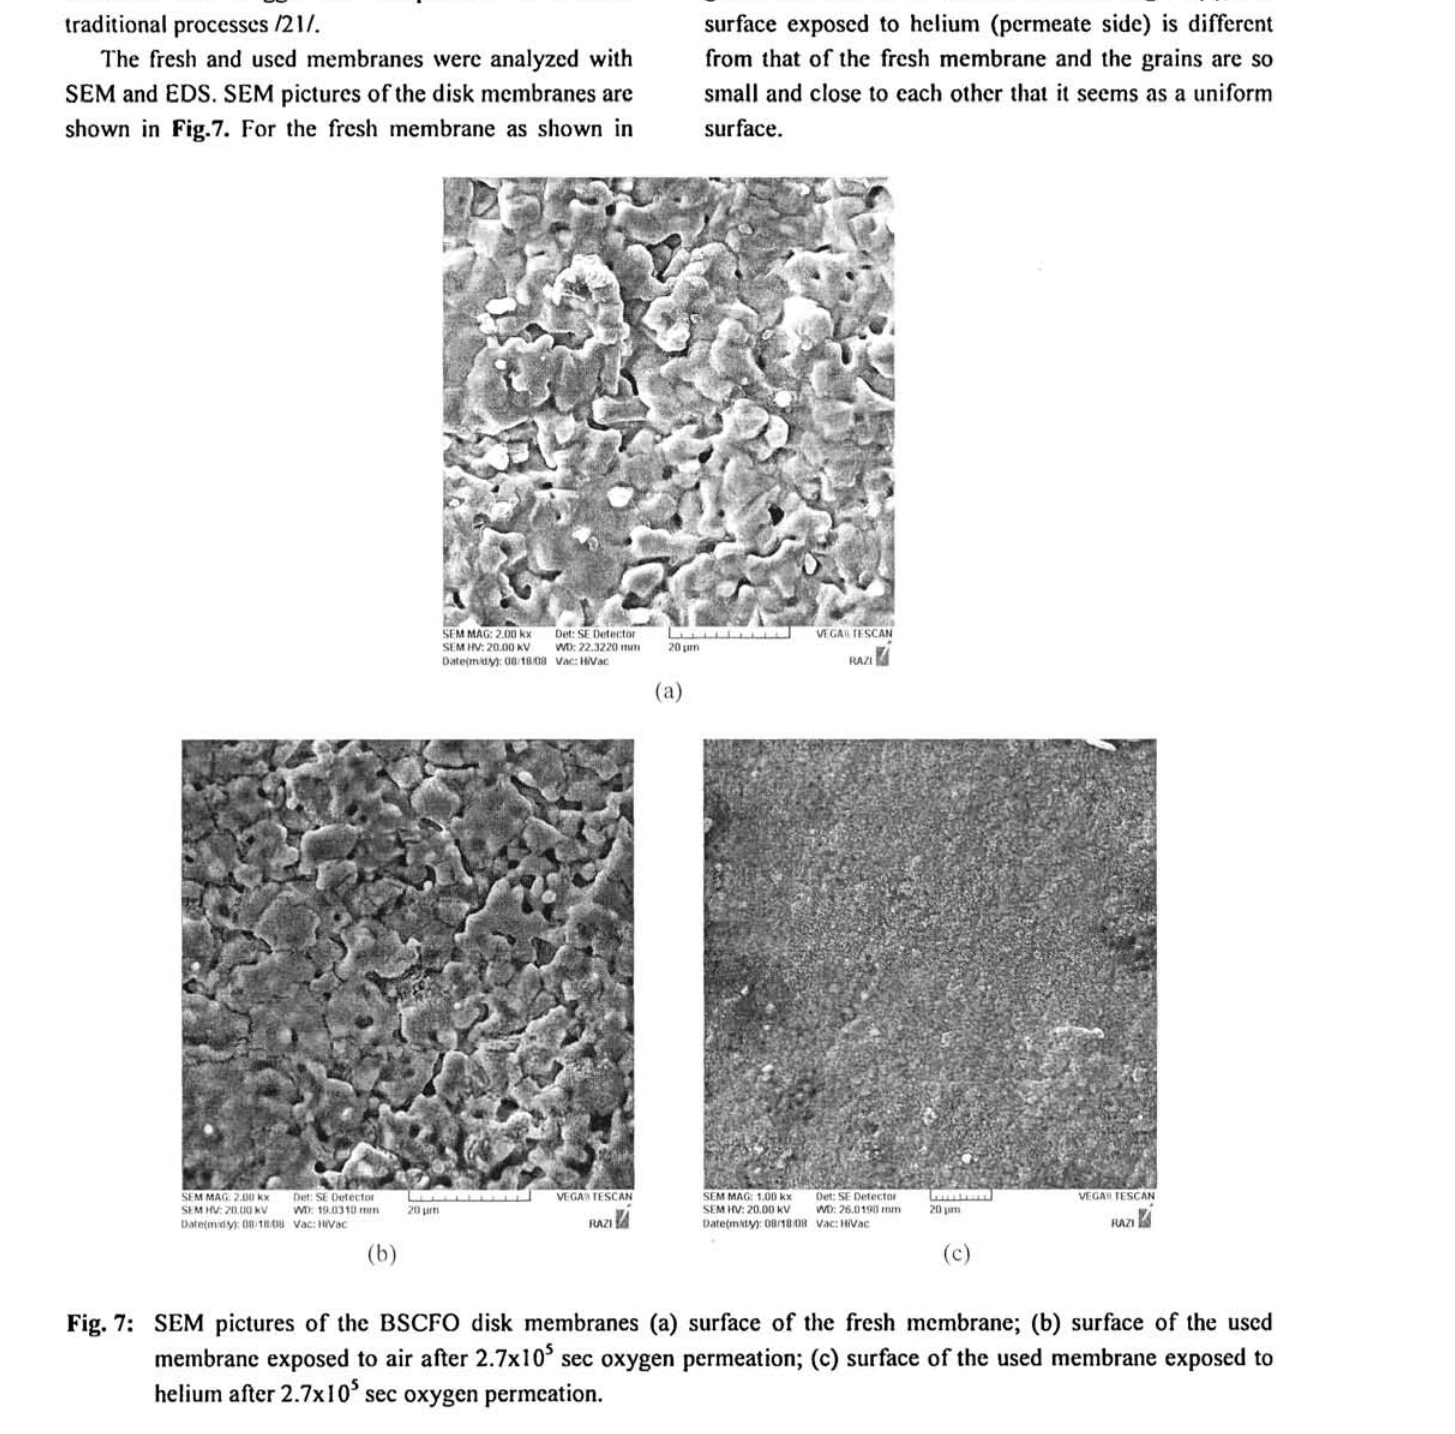
Fig. 7: SEM pictures of the BSCFO disk membranes (a) surface of the fresh membrane; (b) surface of the used membrane exposed to air after 2.7x10 5 sec oxygen permeation; (c) surface of the used membrane exposed to helium after2.7xI0 5 sec oxygen